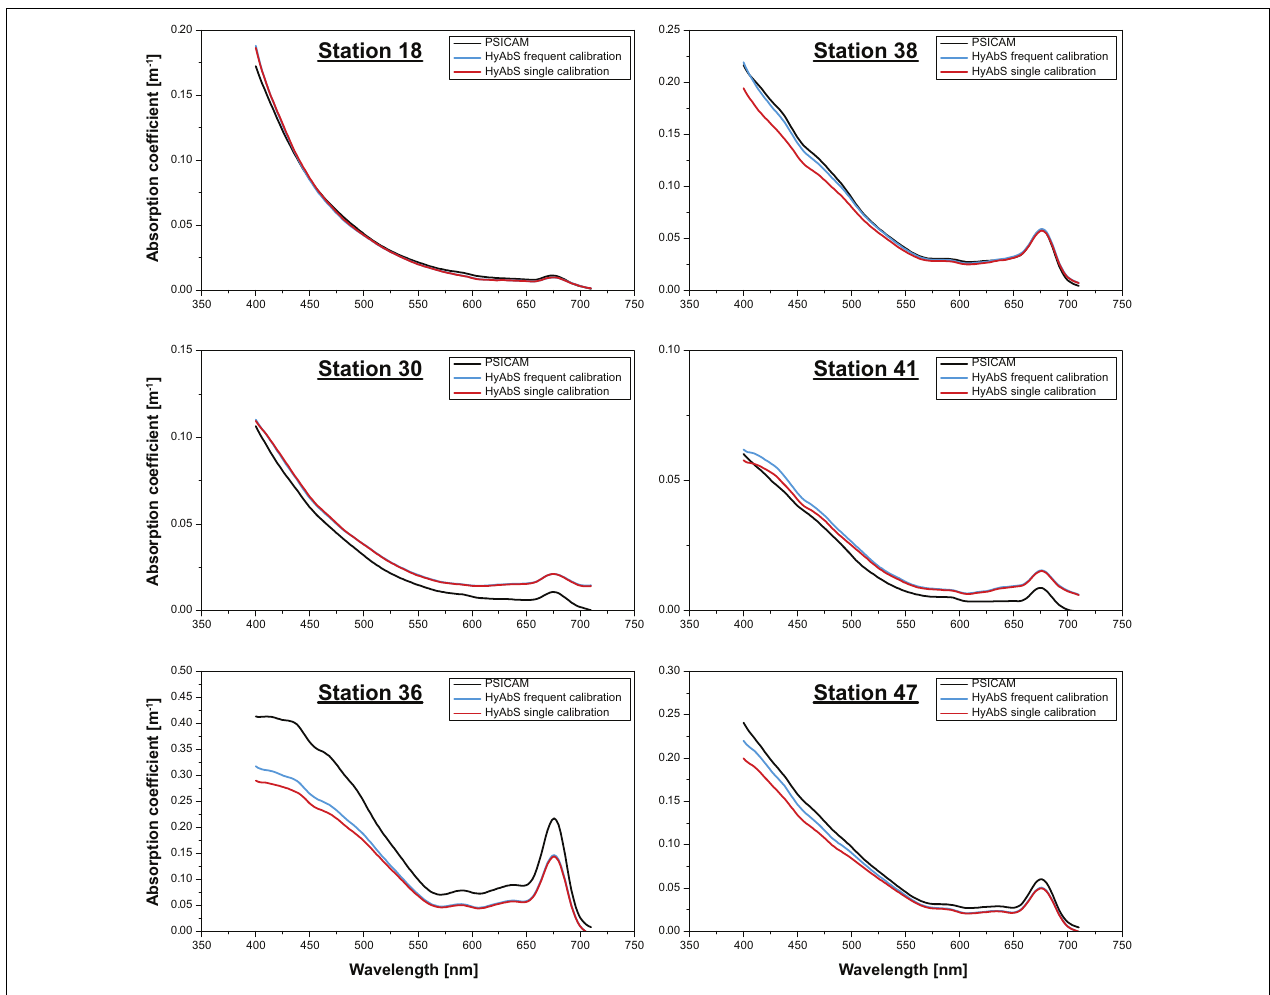
FIGURE 9 | Example comparisons of absorption coefficient spectra between PSICAM and HyAbS at different stations during the cruise HE516.